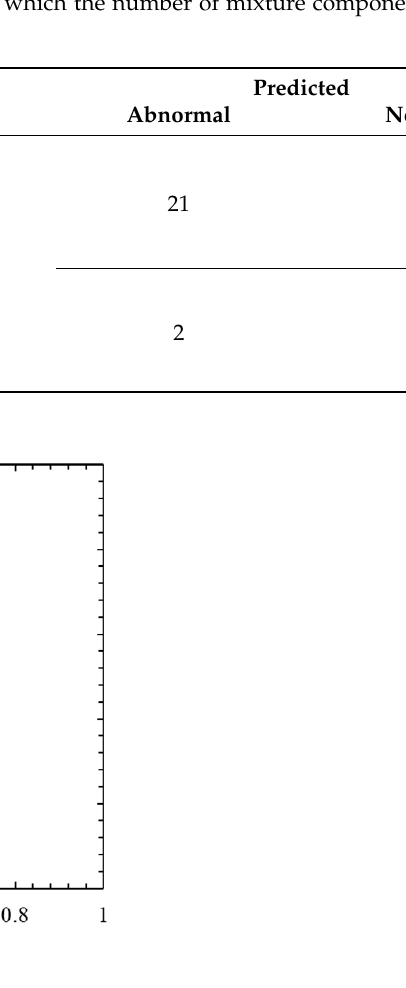
Figure 15. ROC curve of the model in which the number of mixture components K was 256 (threshold is 100th percentile’s value).